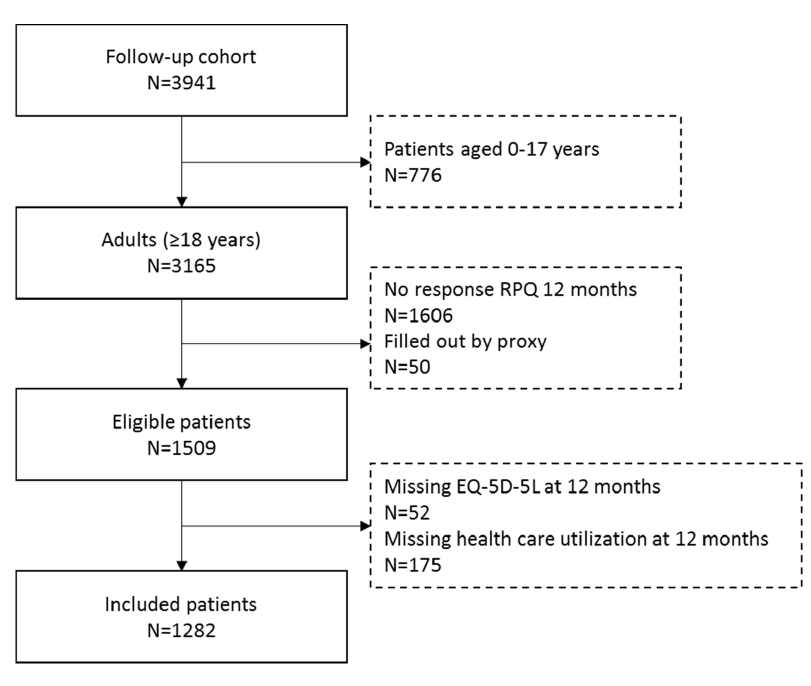
Figure A1. Flowchart. Table A1. Logistic regression model assessing risk factors of PCS twelve months after injury, separately for patients with and without head injury.